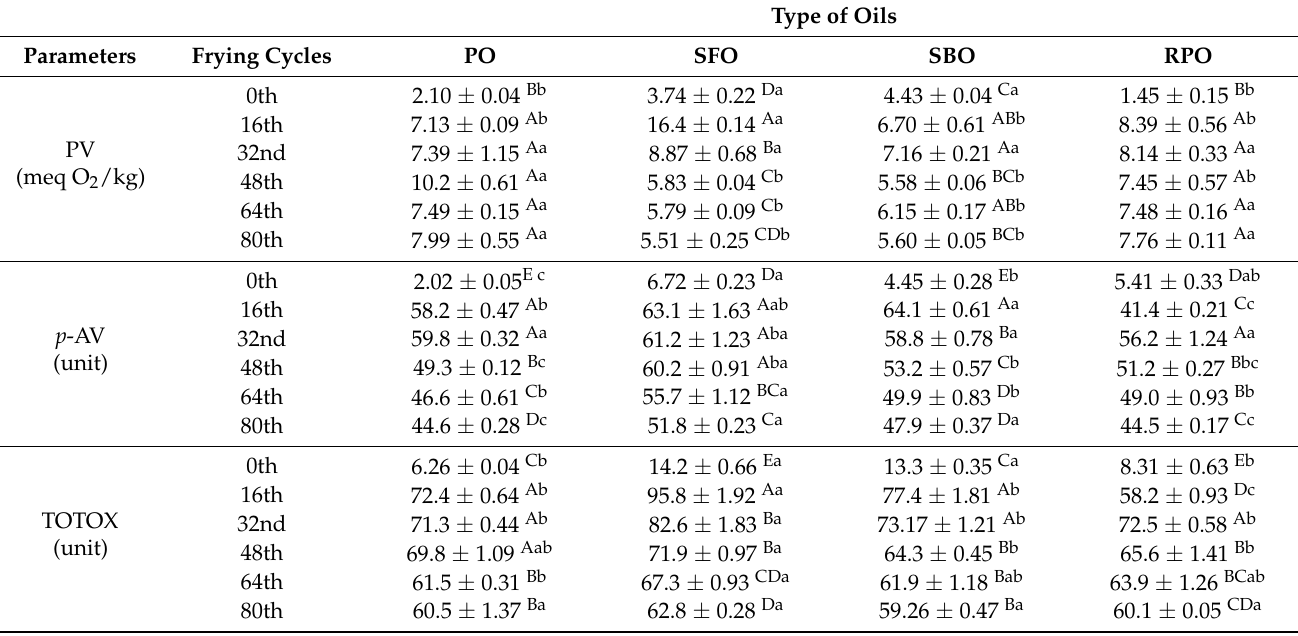
Table 1. Values of oxidative rancidity indexes (PV, p -AV, and TOTOX) of different vegetable oils across 80 frying cycles.